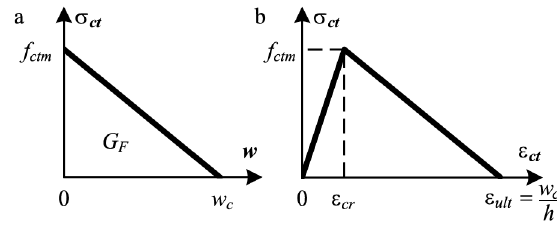
Fig. 5. Tension-stiffening models based on stress-crack width (a) and average stress-strain (b) relationships